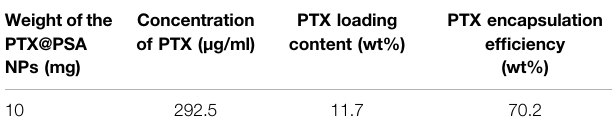
TABLE 1 | The PTX loading content and encapsulation ef fi ciency of PTX@ PSA NPs. Weight of the PTX@PSA NPs